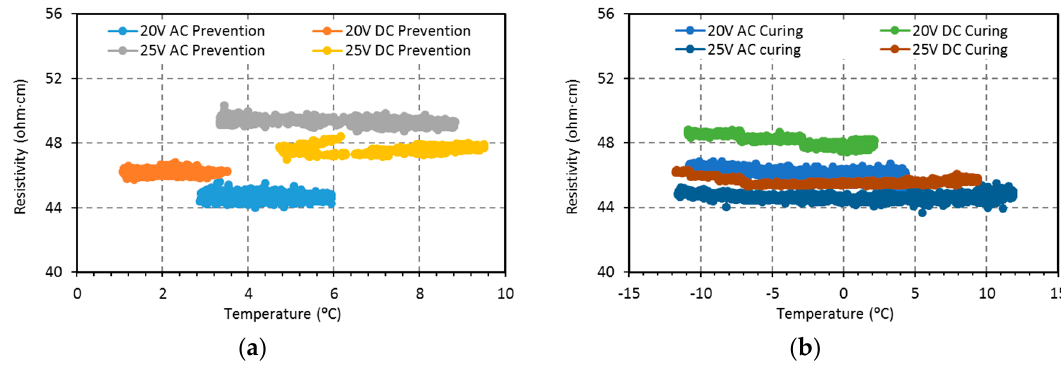
Figure 4. Variation of electrical resistivity with temperature: ( a ) 20 V and 25 V, AC and DC, prevention test; ( b ) 20 V and 25 V, AC and DC, curing test.